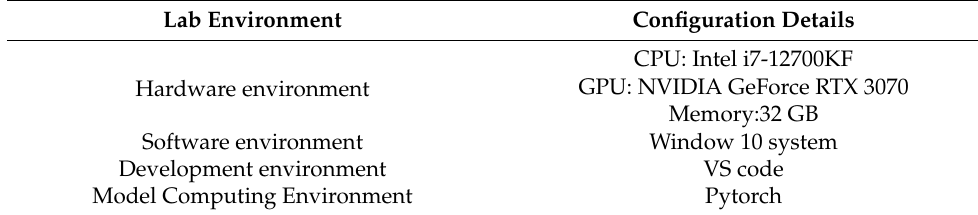
Table 2. Experimental hardware and software environment configuration.